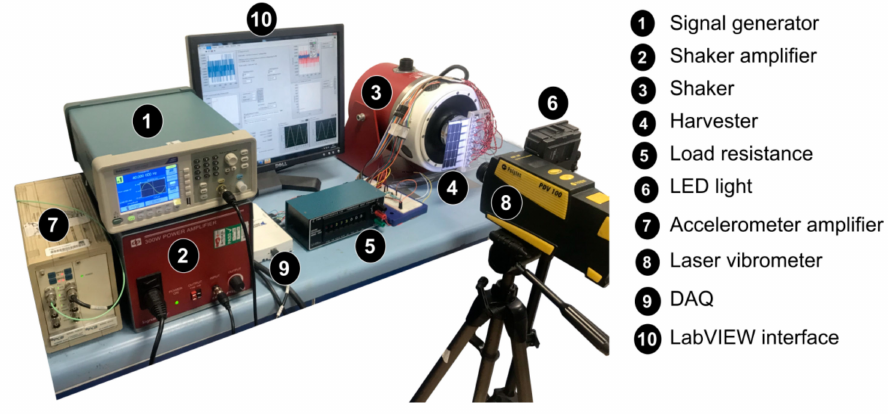
Figure 2. Experimental set-up used in the current